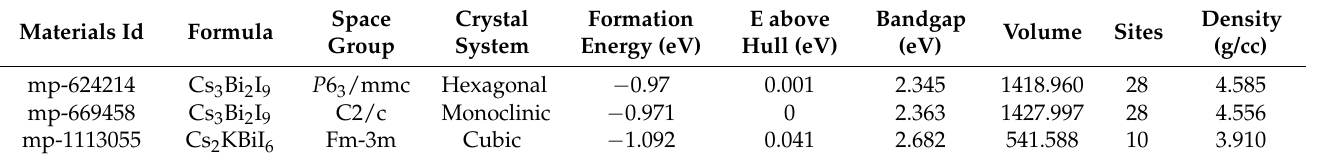
Table 1. Lattice structures and calculated bandgaps of Cs 3 Bi 2 I 9 for the P6 3 /mmc, C2/c, and Fm-3m structures.